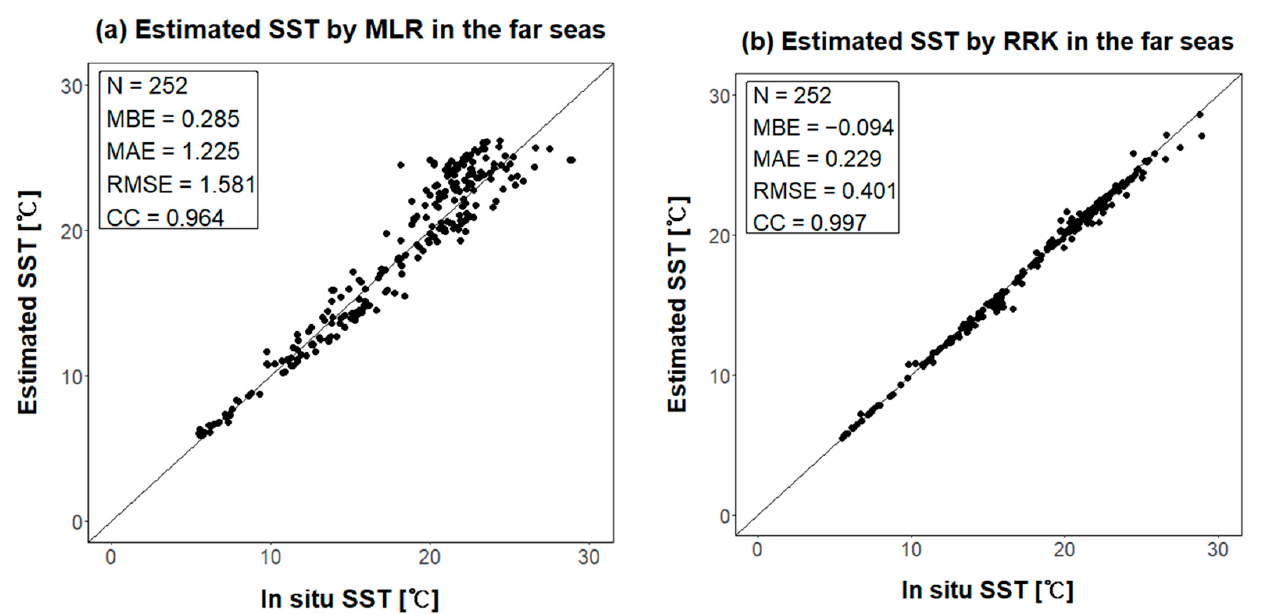
Figure 16. Scatter plots of the ( a ) MLR and ( b ) RRK gap-filling using the GK2A SST images with the null pixel ratio less than 0.4 in the far seas (outside 30 km buffer).